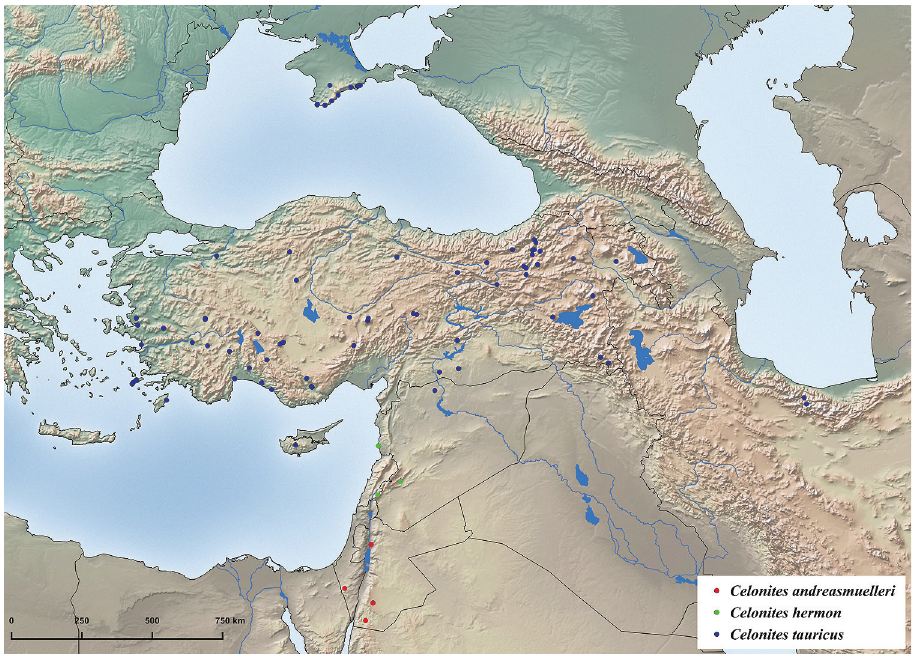
Figure 11. Geographic distribution of the species of the Celonites abbreviatus -complex occurring in the Middle East. Records of Celonites andreasmuelleri taken from Mauss 2013 and Mauss unpublished, records of Celonites tauricus according to Mauss et al. 2016 and Mauss